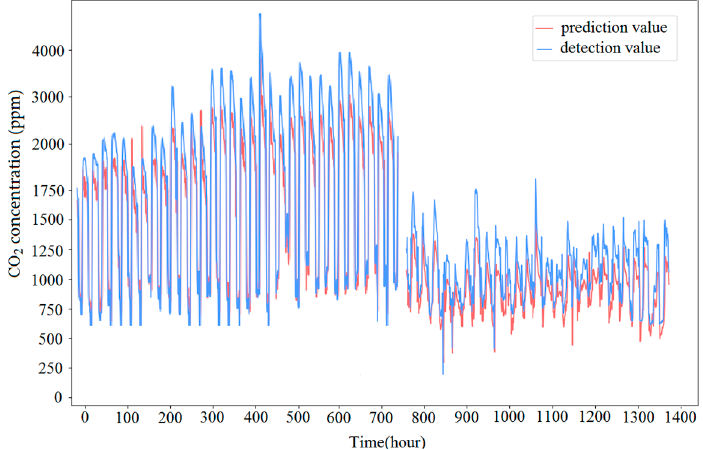
Figure 4. Prediction results of BP model. Note: The data on the left are autumn and winter, the data on the right are spring and summer.